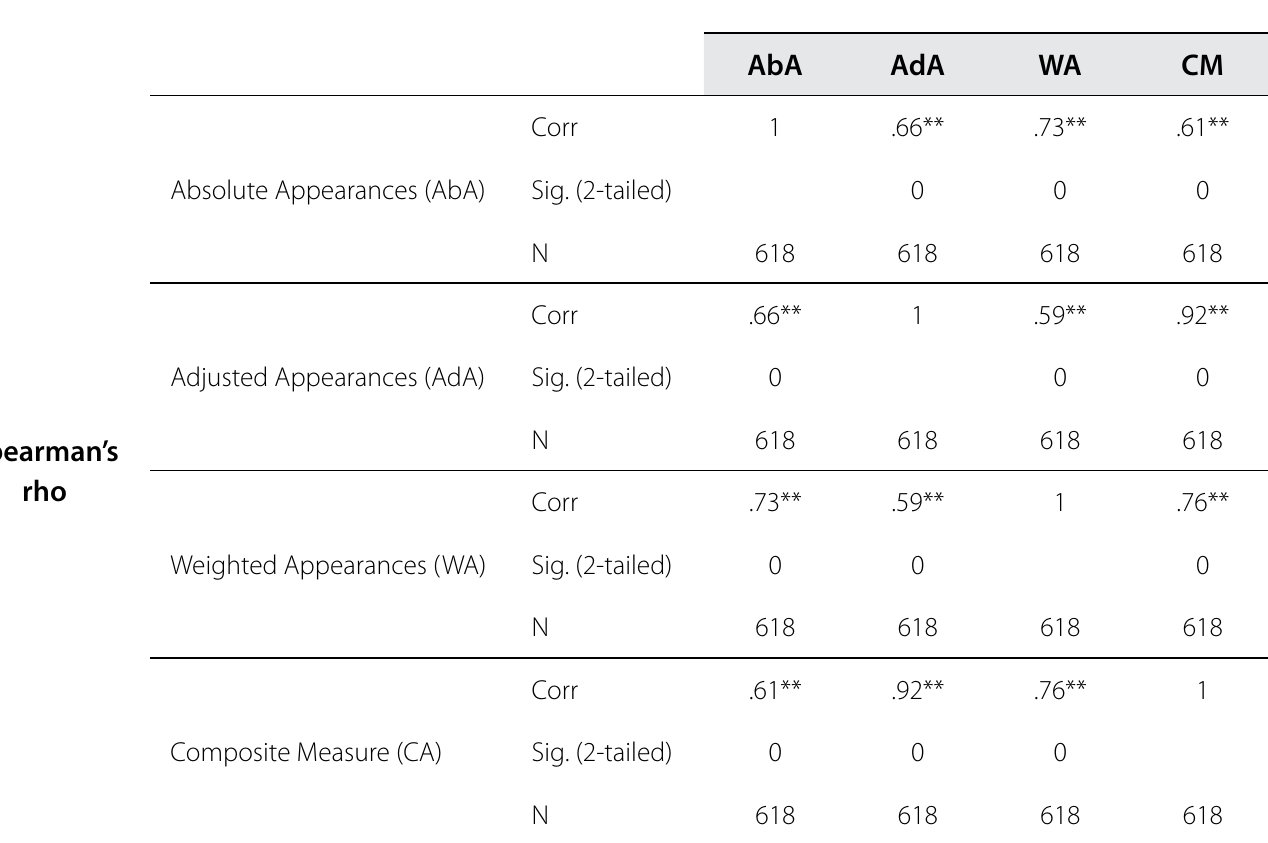
Table 7. Spearman Rank Correlation of Author Impact